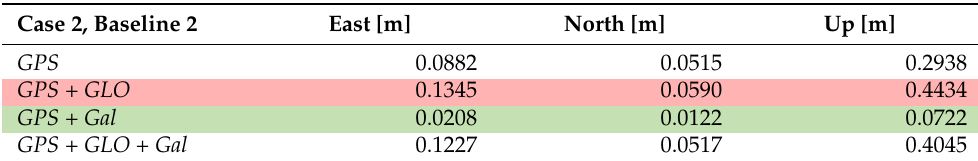
Table 6. Position standard deviation in east, north, and up direction during the jamming incident of Case 2, baseline 2 (12.1 km)—the full 3D positioning error is shown in Figure 11. The solution is based on L1 + L2 phase data. The solution with the least error and largest errors are highlighted in green and red, respectively.